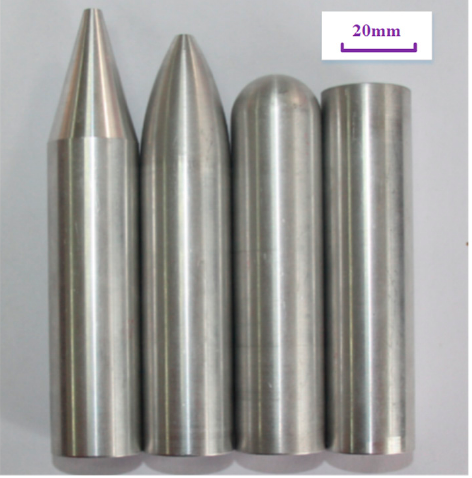
Figure 2. Photograph of (left to right) truncated conical, truncated ogive, hemispherical, and blunt projectiles.